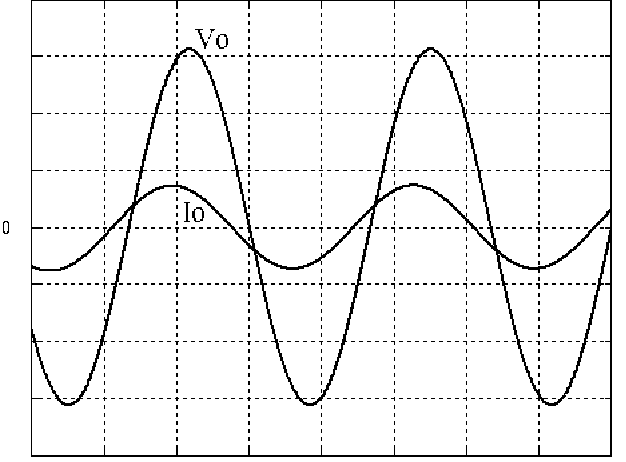
Figure 9. Simulated output waveforms with the proposed controller at capacitive load (vertical: 50 V/div and 20 A/div; horizontal: 5 ms/div).